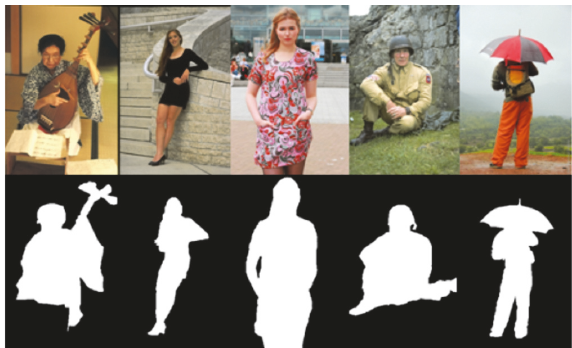
Figure 1: Salient object or